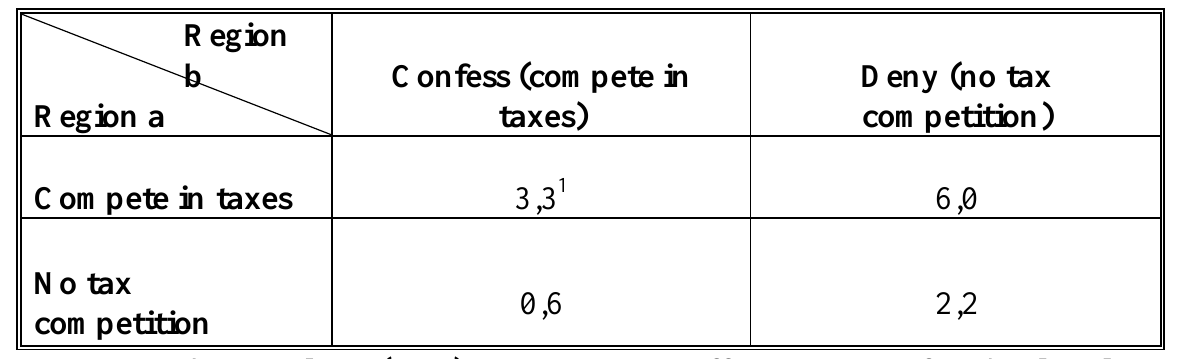
Prisoner’s dilemma facing two regions on tax policy